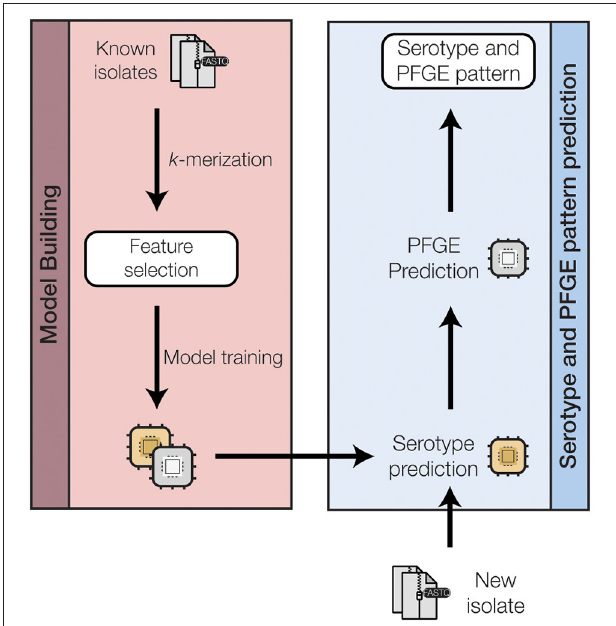
FIGURE 2 | A schematic of the machine-learning approach used to train and test a random forest classifier to predict the O-serogroup and PFGE pattern of STEC genomes directly from raw sequence reads. A more detailed representation for each model training step is shown in Supplementary Figure 2 in the Supplementary Materials .